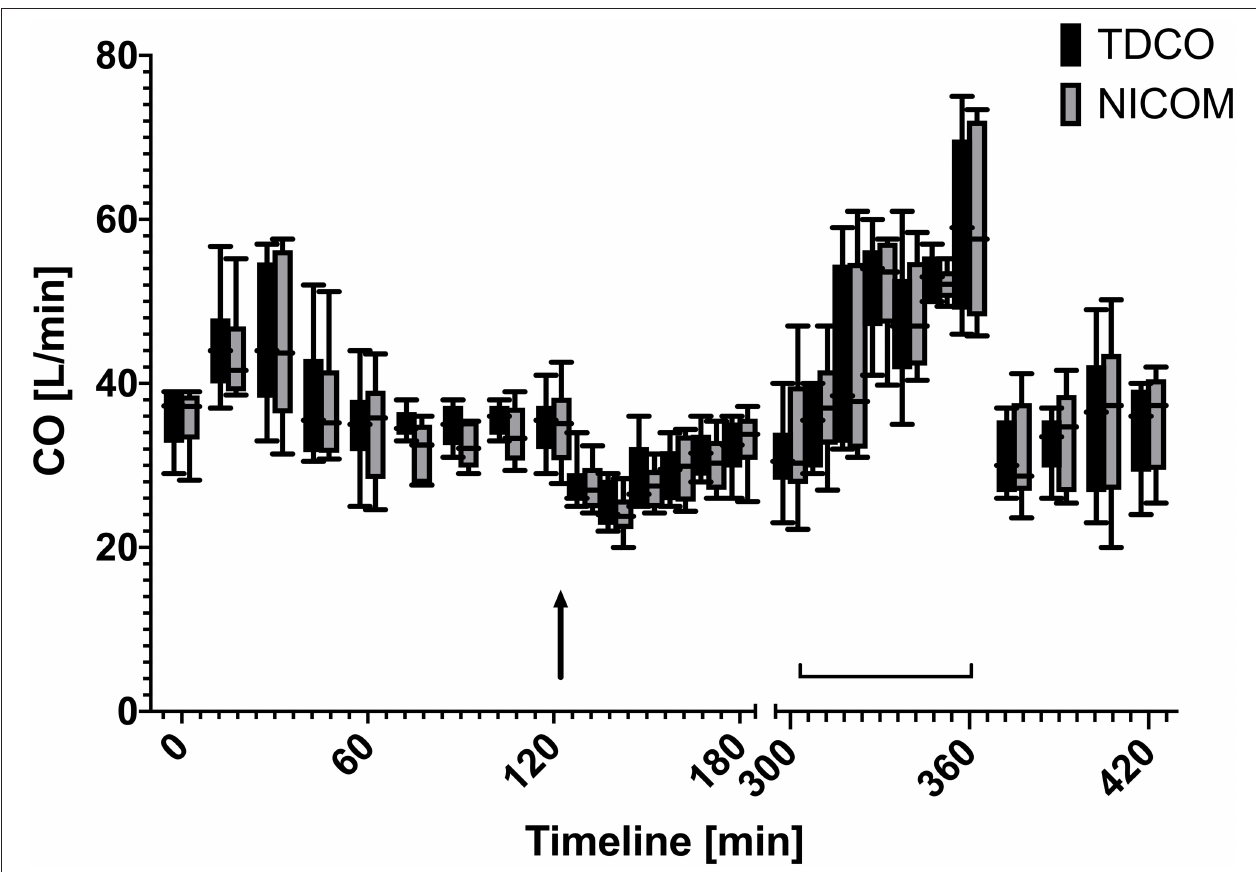
FIGURE 2 | Box and whiskers plot of cardiac output values over time measured using thermodilution (TDCO) and corrected bioreactance (NICOM) values ( × 1.962) at different time points during rest, after xylazine bolus (125min, black arrow), and during dobutamine CRI (305–360min, brackets).